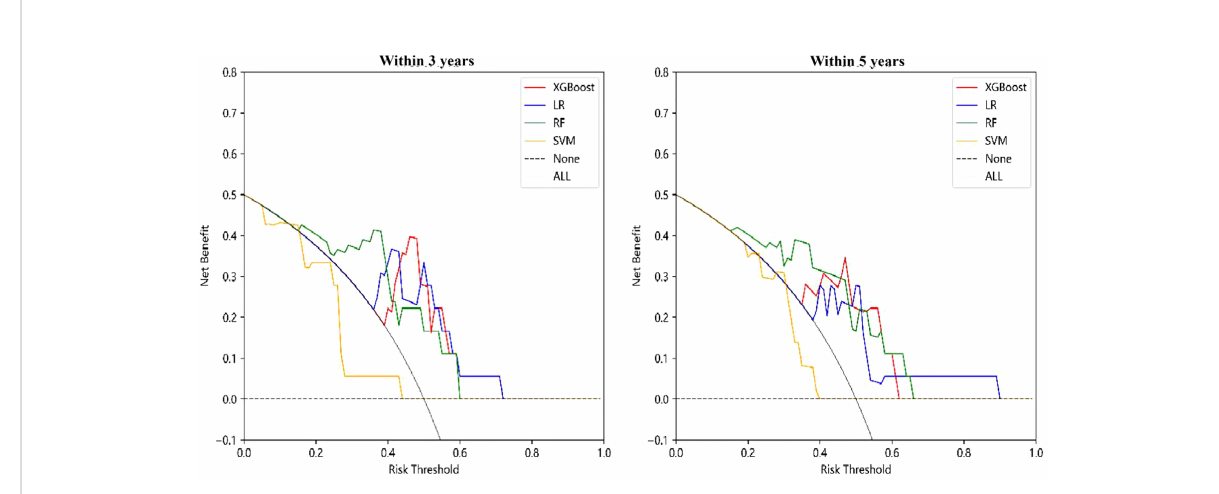
FIGURE 5 DCA curve of “ TCM syndrome prognostic model ”